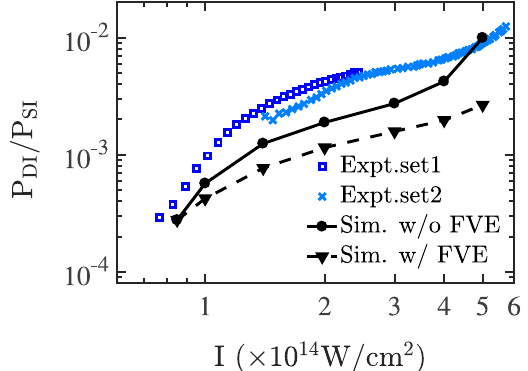
Figure 1. Ratio of double to single ionization probability as a function of intensity. Experimental results 8 are denoted by dark blue squares and light blue crosses and computed results are presented by a solid line with black circles when the focal volume effect is not accounted for and by a dashed-line with triangles when the focal volume effect is accounted for. The difference in the two experimental sets results from slightly different averaging over the focal volume 8